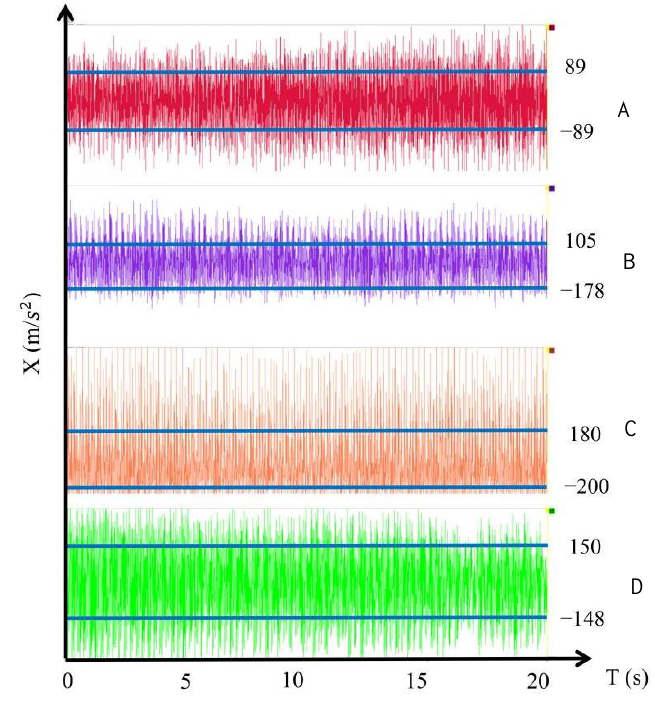
Figure 21. Vibration response of the original shell.